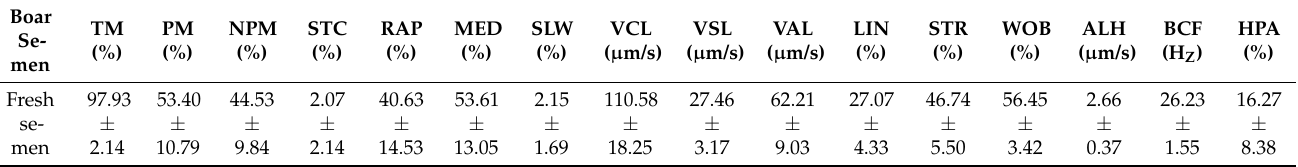
Table 3. Evaluation of sperm viability and morphology traits of fresh semen from Large White boars.